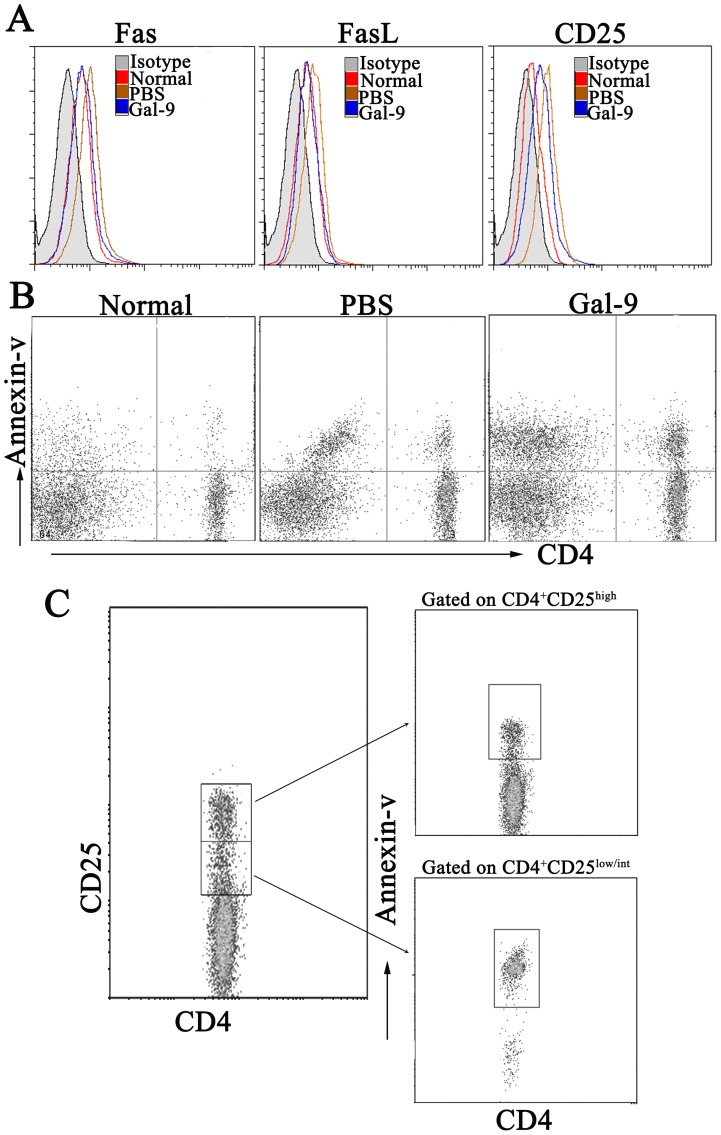
Galectin-9 induced apoptosis of CD4+ T cells in vivo. Galectin-9 (100 µg per mouse) or PBS was administrated i.v. to Balb/c mice (n = 8 per group) 30 min before Con A injection (20 mg kg–1). The splenocytes were isolated 24 h later. (A) Fas, FasL and CD25 expression on CD4+ T cells are shown. (B) Apoptosis of CD4+ T cells was analyzed by FACS. (C) Differentially induced apoptosis of CD4+ effector T cells and regulatory T cells by galectin-9 in Con A treated mice. Similar results were obtained in 3 separate experiments and the representative results were shown. Normal, normal mice; PBS, PBS pretreatment in Con A-treated mice; Gal-9, galectin-9 pretreatment in Con A-treated mice.